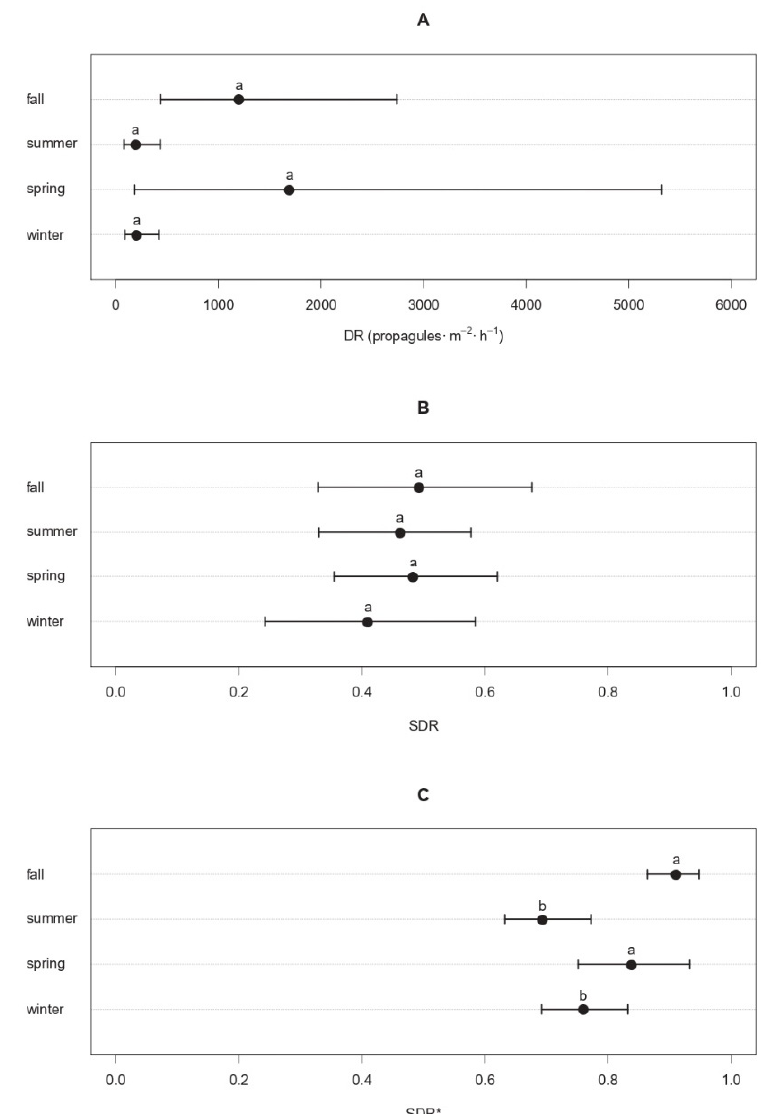
Figure 2. Seasonal patterns of the propagule deposition of Cryphonectria parasitica . Dots represent the mean rate of propagule deposition (DR) in propagules·m − 2 ·h − 1 (panel A ), the average standardized deposition rate (SDR, panel B ), or the average SDR of C. parasitica over the baseline of 60 propagules·m − 2 ·h − 1 (SDR*, panel C ) for each season. Whiskers around the dots refer to the 95% confidence intervals. Different letters are used to highlight significant differences ( p < 0.05). Instead, no significant effects of the calendar month (MS) of sampling on SDR* were detected ( c = 0.189 and p = 0.887). The cosine regression model showed that the average